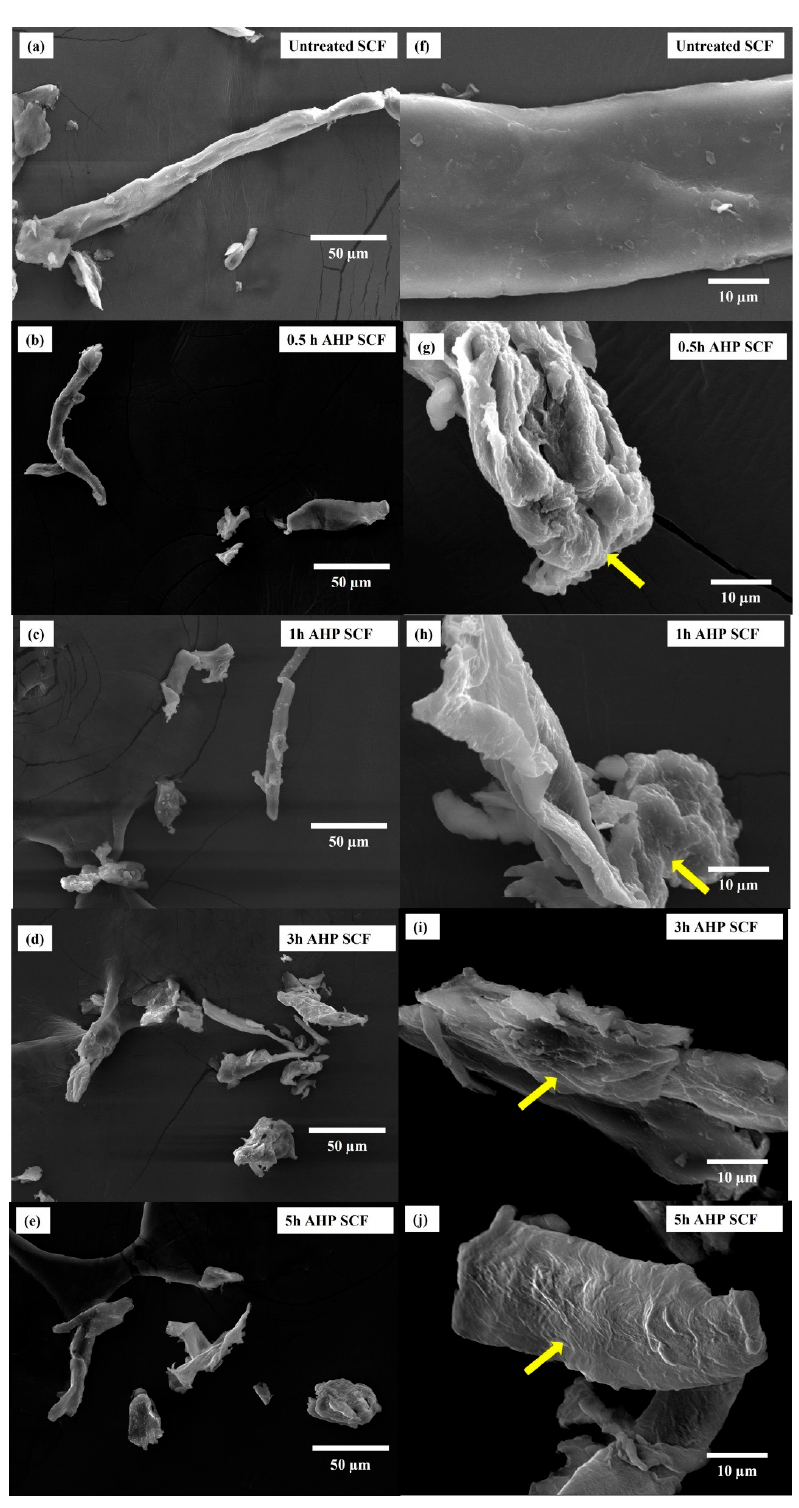
Figure 3. Morphological images of untreated and AHP SCF detected by SEM at ( a – e ) 500× magni fi - cation and ( f – j ) 2000× magni fi cation. Yellow arrows indicate surface di ff erences.